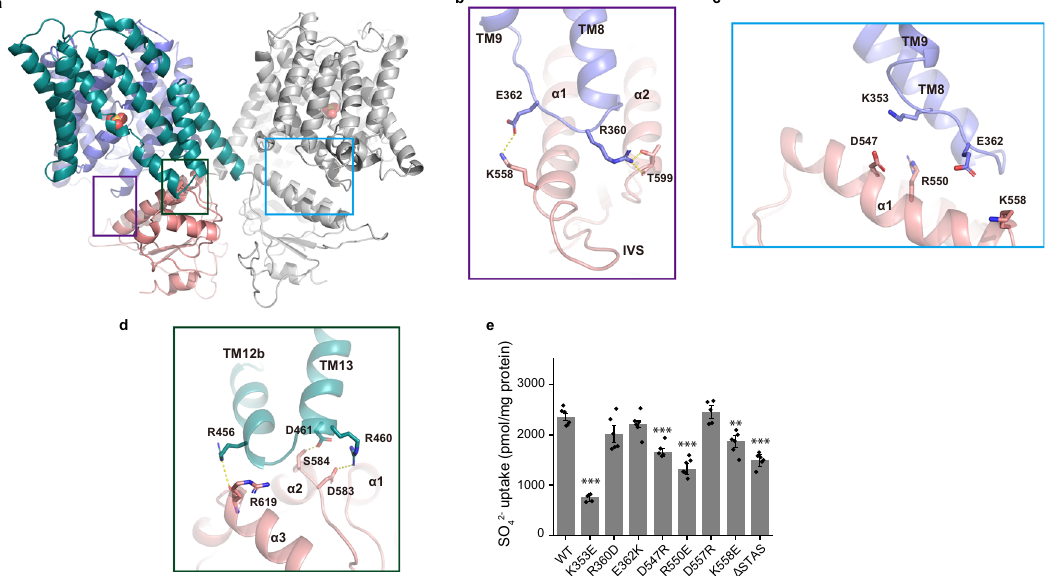
Fig. 4 AtSULTR4;1 STAS and TM interaction. a Structure of AtSULTR4;1. The TM domain of one protomer is violet and teal (for the core and gate domains, respectively), and the STAS domain from the other protomer is pink. The boxes are enlarged in ( b – d ) to show the STAS-core and STAS-gate interactions, respectively. e SO 4 2 − transport activities of charge-reversal mutants and the Δ STAS construct. The height of the columns represents the average of 5 – 6 repeats from 2 batches of liposomes independently prepared. n = 5 for K353E, D547R, and D557R, and n = 6 for all others. Error bars indicate s.e.m. of the average. A two-tailed Student ’ s t test was applied to selected data. *** indicates p < 0.0001 compared to WT; ** indicates p < 0.001. Exact p values can be found in the Source Data fi